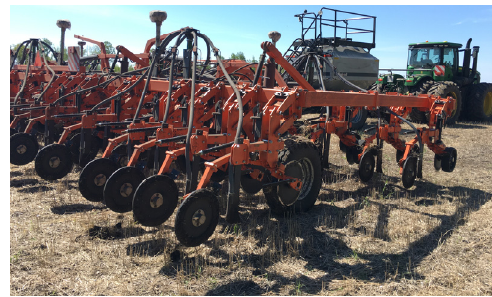
Figure 19. PK-12.7 sowing complex equipped with combined sowing sections